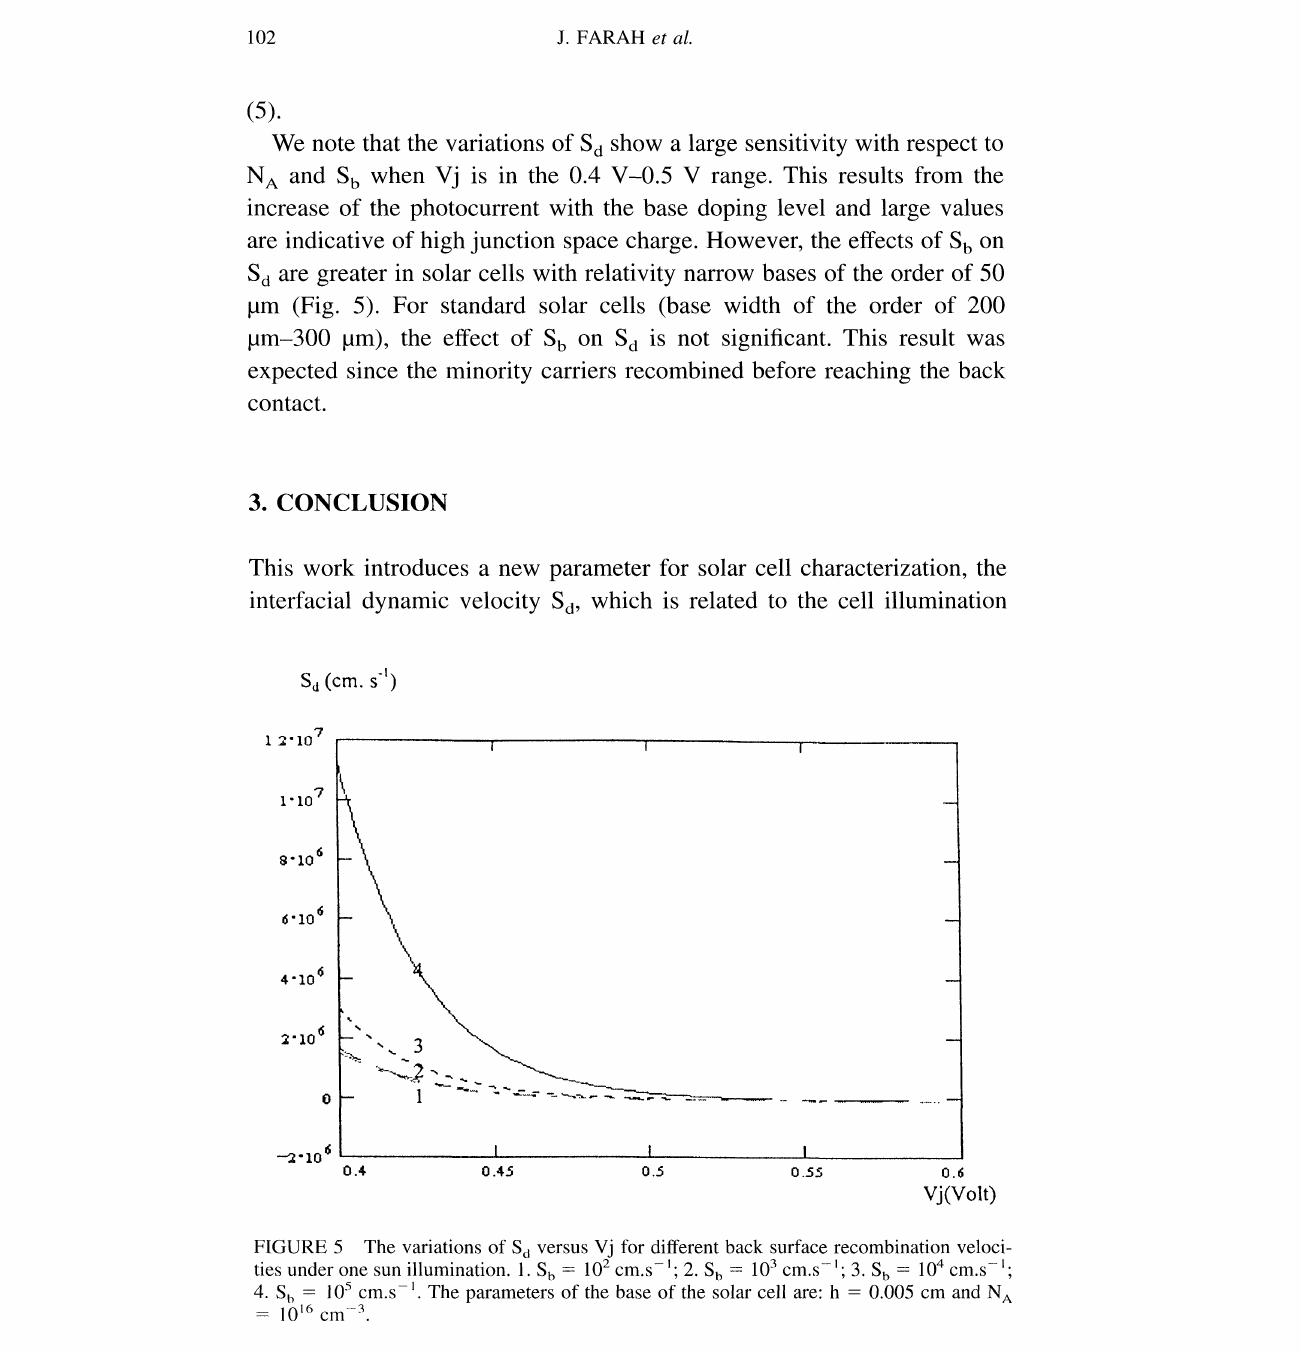
FIGURE 5 The variations of Sd versus Vj for different back surface recombination veloci- -. ties under one sun illumination. 1. Sb 102 cm.s -" 2. Sb 10 cm.s-’" 3. Sb 104 cm.s-l; 4. Sb 105 cm.s The parameters of the base of the solar cell are: h 0.005 cm and N cm